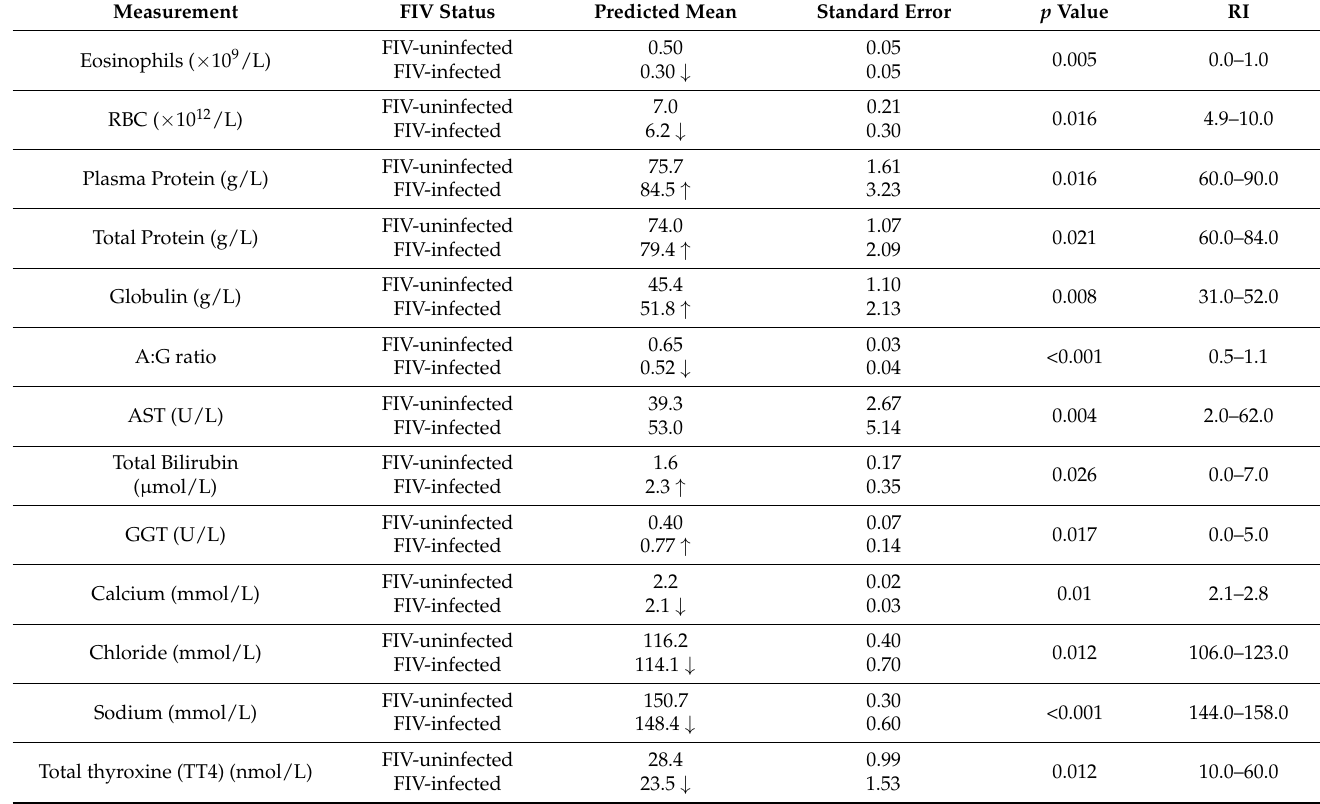
Table 5. Comparison of hematology and blood biochemistry results for cats in cohort 2 ( n = 282; external hematology and blood biochemistry testing). Only significant differences are shown (13 out of a total of 39 measurements analysed), with up ( ↑ ) and down ( ↓ ) arrows signifying significantly different mean values in FIV-infected cats compared to FIV-uninfected cats. RI = reference interval, WBC = white blood cell count, RBC = red blood cell count, Hb = hemoglobin, MCV = mean corpuscu- lar volume, MCHC = mean corpuscular hemoglobin concentration, A:G = albumin to globulin ratio, AST = aspartate aminotransferase, GGT = gamma glutamyl